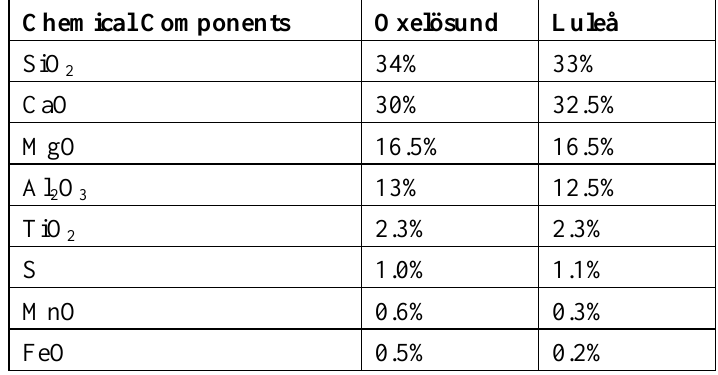
Table 1. Example of the chemical composition of the crystalline blast furnace slag materials (0–8 mm) produced in Oxelösund and Luleå